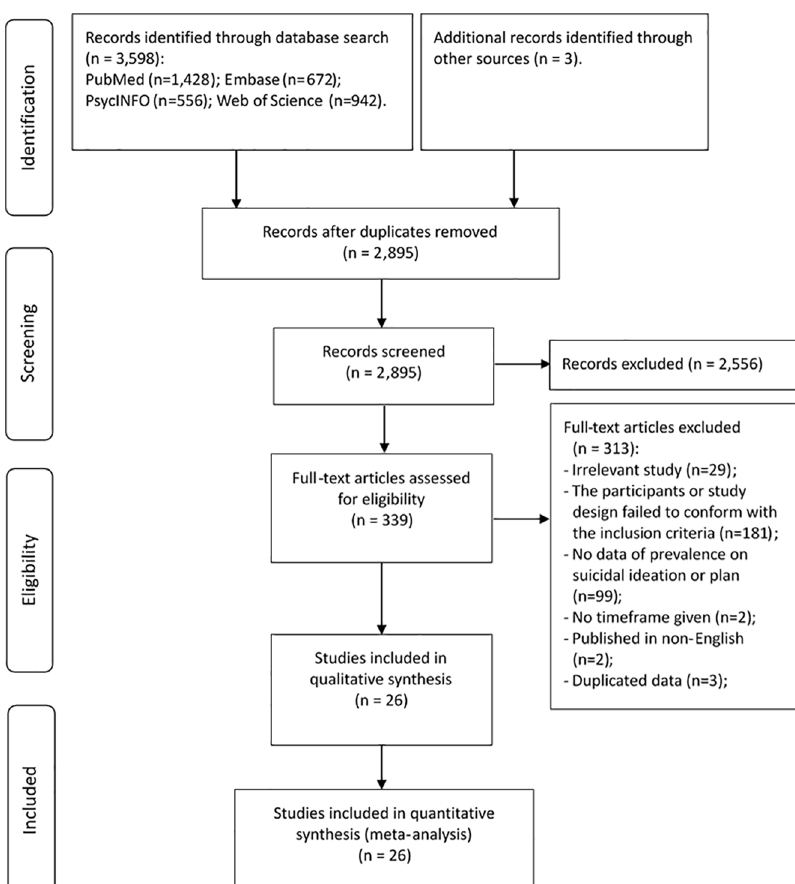
Fig. 1 Flowchart of study selection. This fi gure described the procedure of studies selection. Among 3601 publications identi fi ed through literature search, 26 studies met the inclusion criteria and were